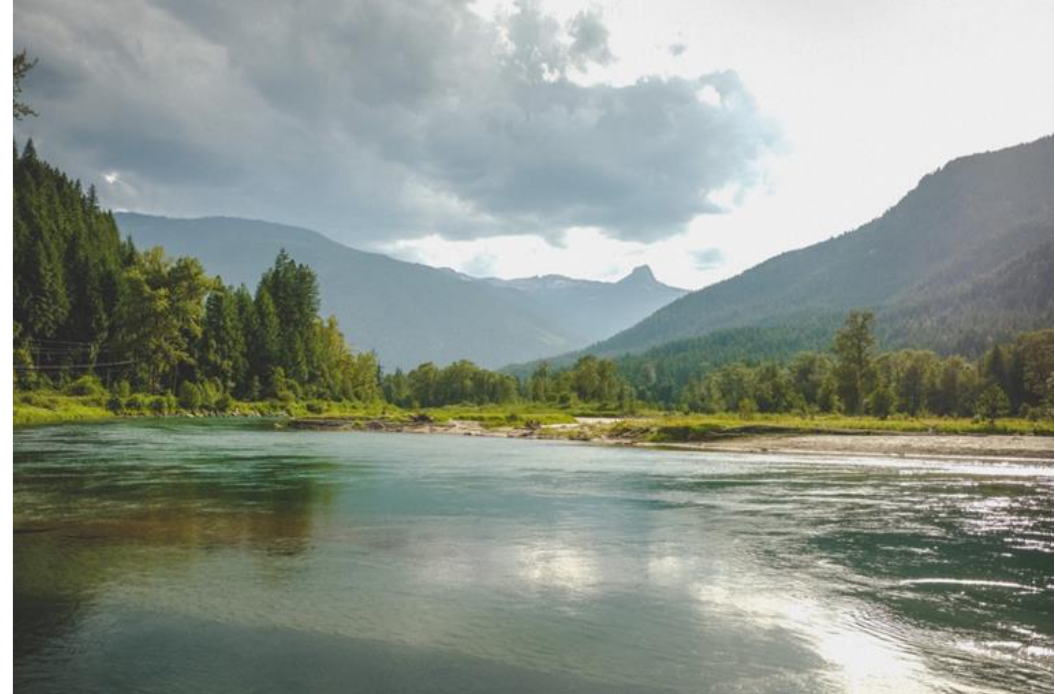
Figure 3: Slocan River eventually joins the Kootenay River and finally the Columbia River which flows into the US and then the sea near Portland, Oregon. Pictured is Frog Mountain a sacred place to Sinixt people. Slocan in the Sinixt dialect means “ speared in the head ” . Selkirk College’s nine campuses are located on the traditional territories of four Nations: the Sinixt (Lakes), the Syilx (Okanagan), the Ktunaxa, and the Secwépemc (Shuswap) peoples. These lands are important to all four Nations. Courtesy: Mike